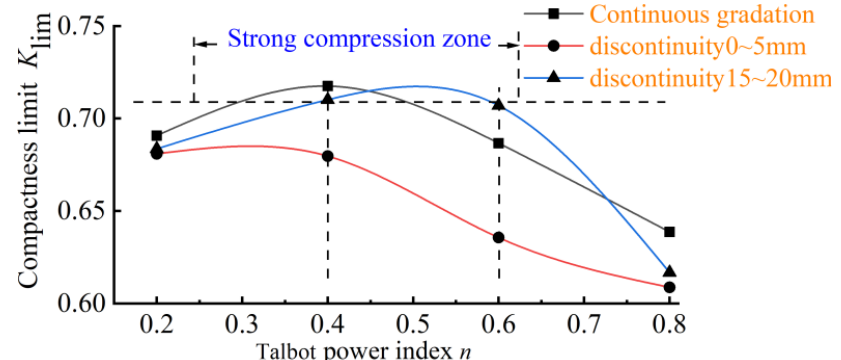
Figure 7. Compaction limit values versus Talbot index.